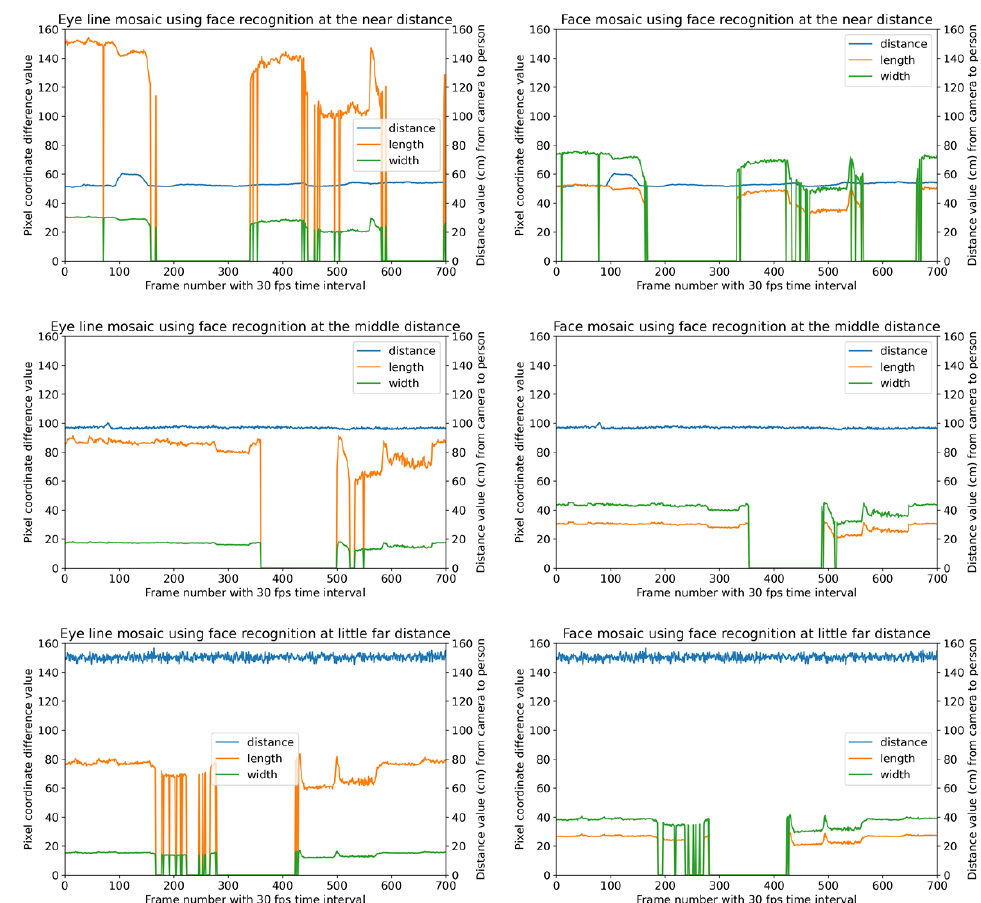
Figure 14. Facial masking results using image-based face recognition in this